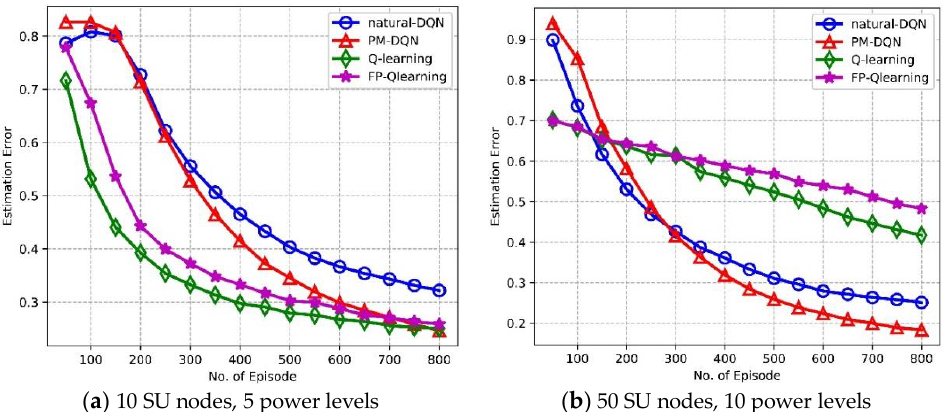
Figure 12. Estimation error vs. the number of episodes.